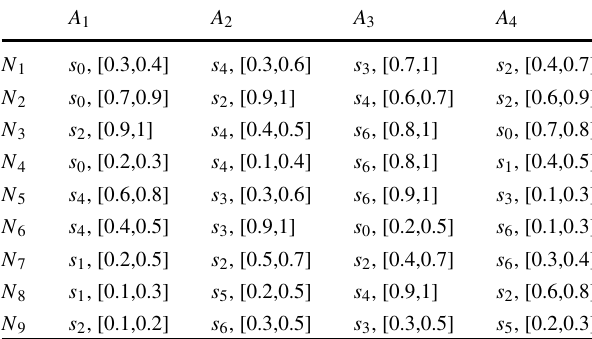
Table 7 The decision matrix with confidence interval values according to the sixth voting node